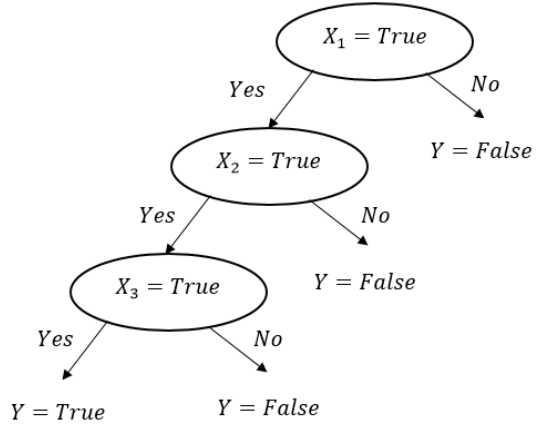
Figure 7. Decision tree representation.